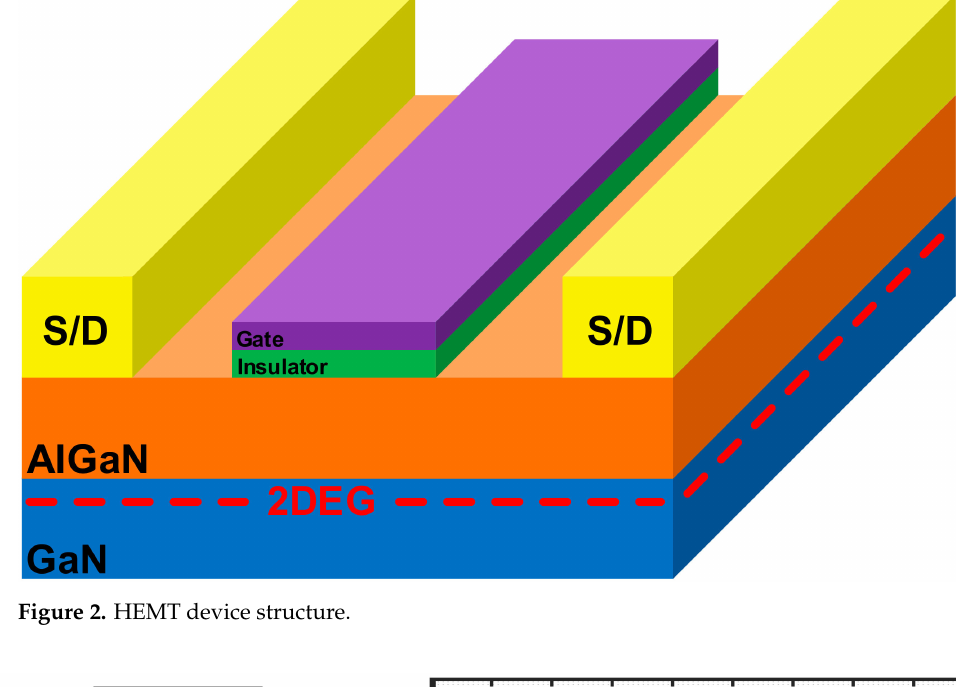
Figure 2. HEMT device structure.